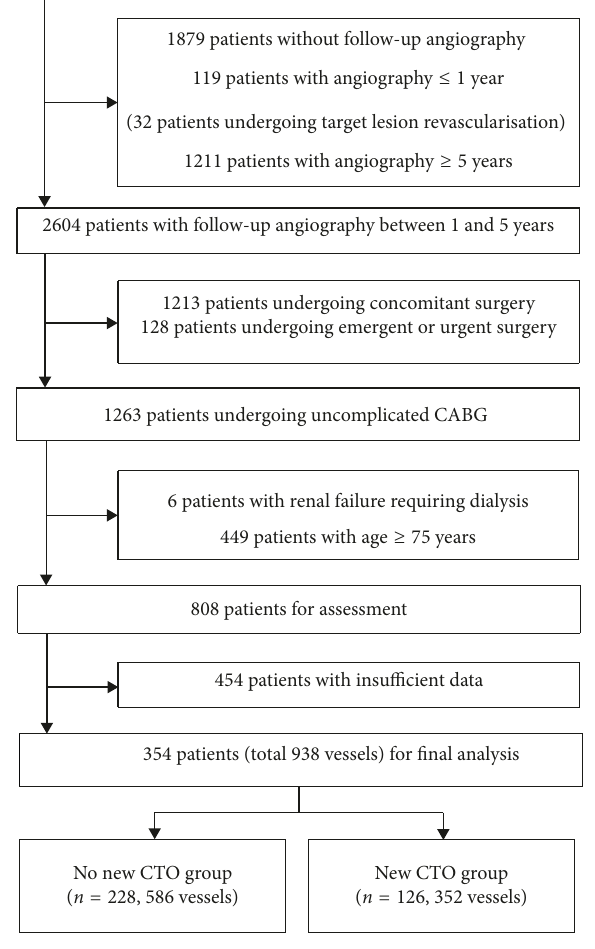
Figure 1: Flow chart of the